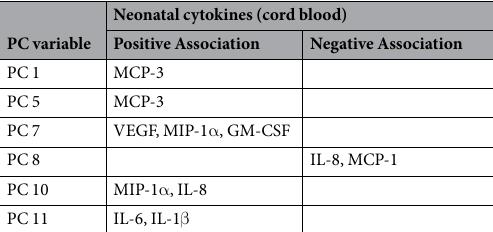
Table 6. Association of EDC mixtures with cord blood